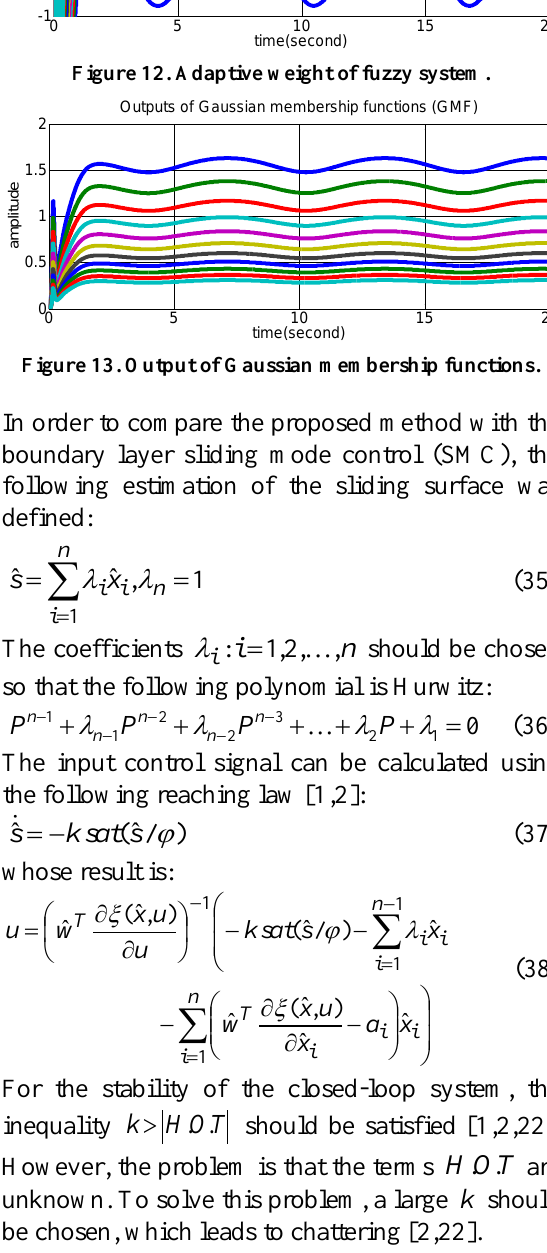
Figure 14. Non-linear system and its fuzzy estimation.